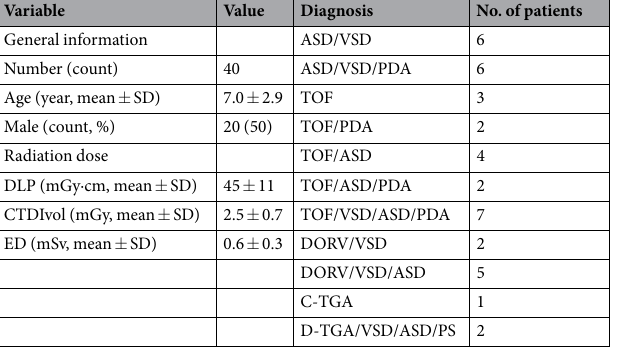
Table 1. Characteristics of the study subject with congenital heart disease. DLP, dose-length product; CTDIvol, CT dose index; ED, effective dose. SD: standard deviation. ASD, atrial septal defect, VSD, ventricular septal defect, PDA, patent ductus arteriosus, TOF, tetralogy of Fallot, DORV, double outlet right ventricle, C-TGA, corrected transposition of great arteries, D-TGA, complete transposition of great arteries, PS, pulmonary